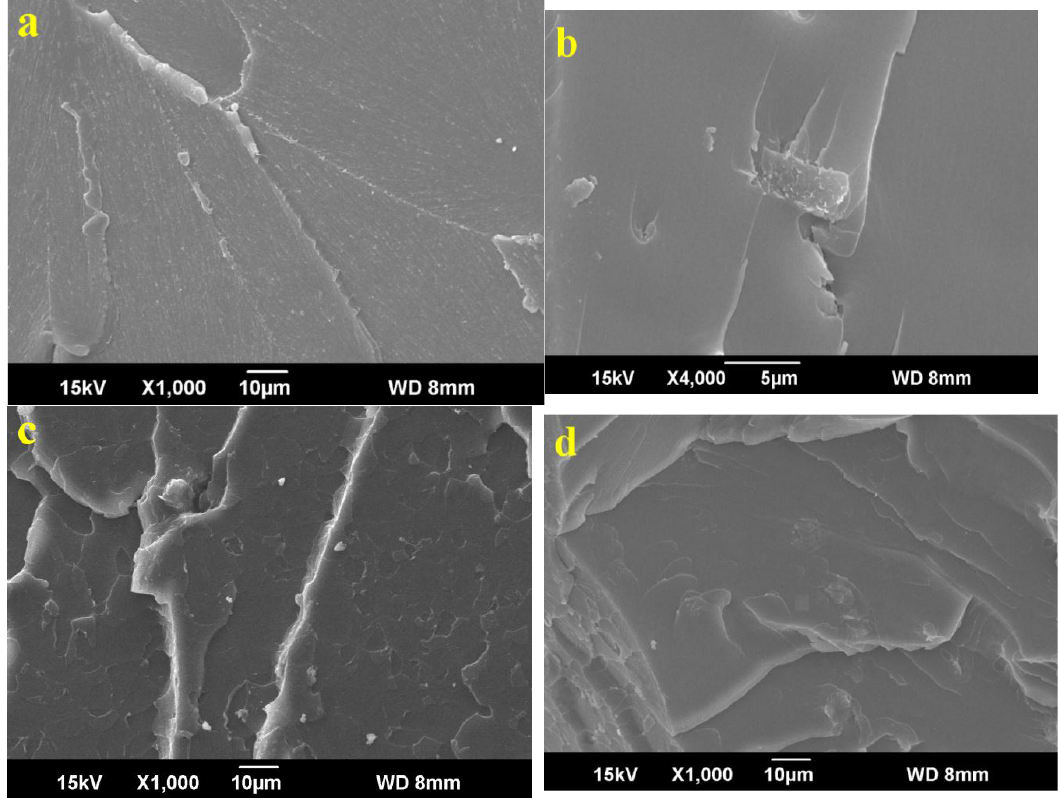
Figure 10. The SEM images of GO/epoxy resin composites with different GO contents of: ( a ) 0 wt %, ( b ) 0.4 wt %, ( c ) 0.8 wt % and ( d ) 1.2 wt % in flexural tests.